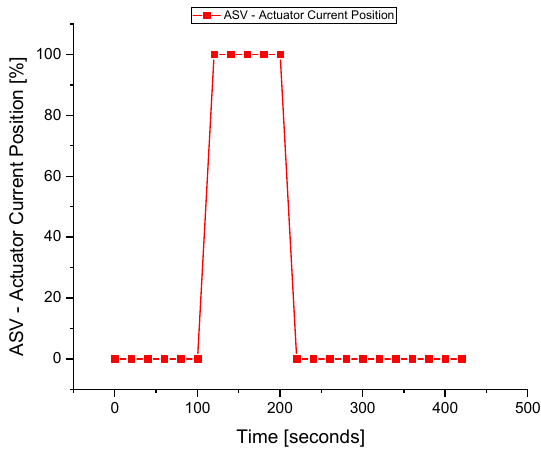
Figure 18. The actuator response during a fault in the T d sensor.